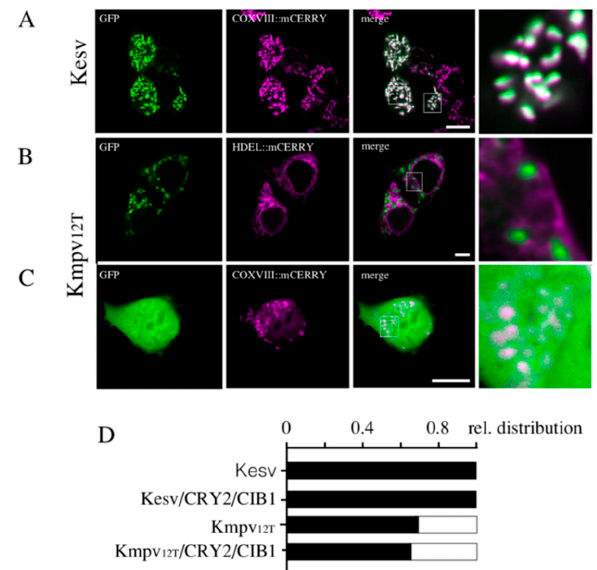
Figure 1. Kesv and Kmpv 12T are sorted to mitochondria. Fluorescent images of HEK293 cells transfected with GFP-tagged Kesv ( A ) or Kmpv 12T ( B , C ). Images show: GFP fluorescence (green, first column), fluorescence from mitochondrial marker (purple, COXVIII::mCherry) or endoplasmic reticulum (ER) marker (purple, HDEL::mCherry) (second column) and merge of purple and green channels (third column). Magnification from areas marked in merged images is shown in the fourth column. Scale bars: 10 μ m. ( D ) Relative distribution of HEK293 cells in which the GFP fluorescence was only present in mitochondria as in (black bars) ( A , B ) or cells in which fluorescence was detected throughout (open bars) as in ( C ). The channel proteins were expressed constitutively or after triggering expression by light (Cry2 / CIB1). Kesv (N = 4, n = 150 cells), Kmpv 12T (N = 2, n = 100 cells) Kesv / CRY2 / CIB1 (N = 22, n = 440 cells), Kmpv 12T / CRY2 / CIB1 Kmpv 12T (N = 11, n = 228